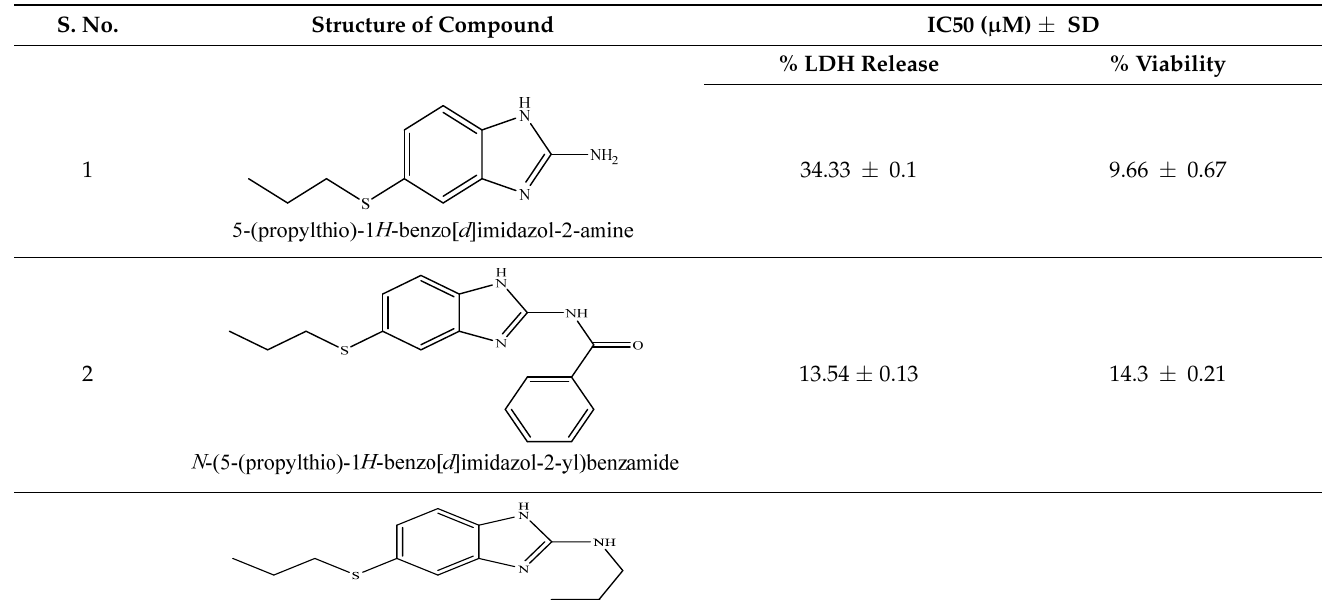
Table 1. Compound structures and formulas with IC50 values.